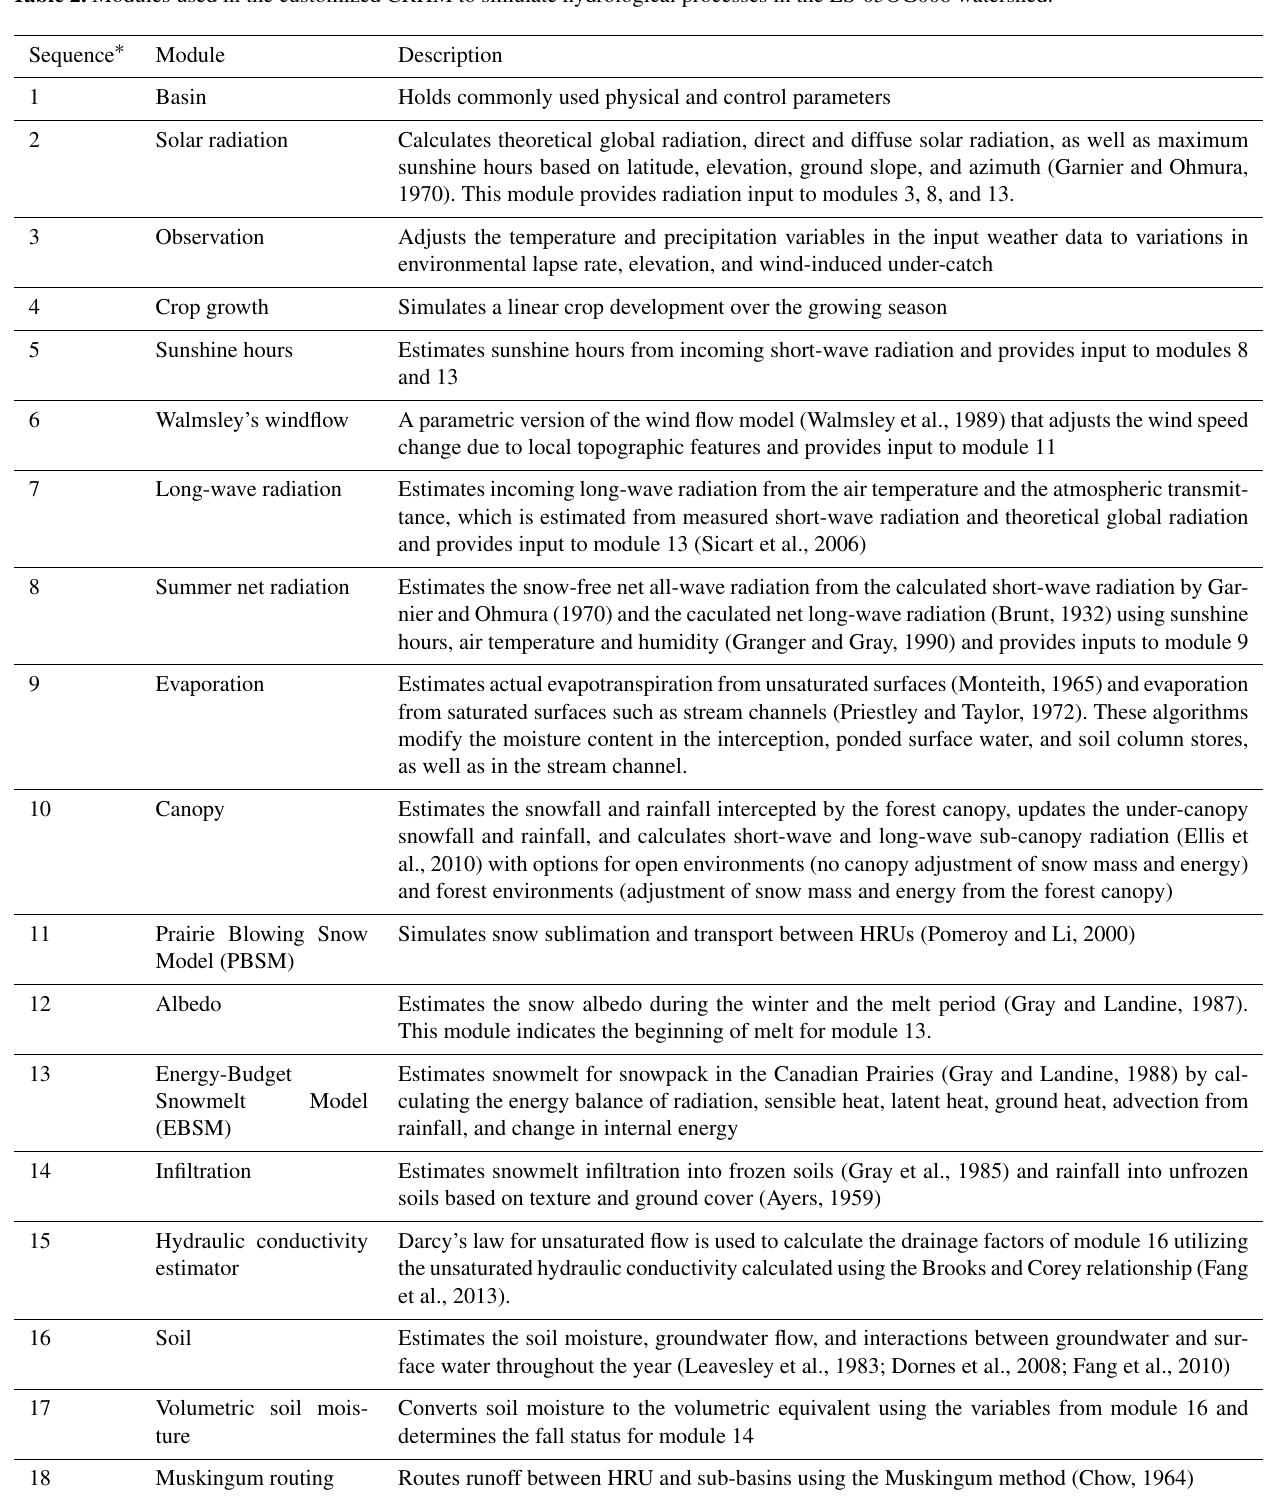
Table 2. Modules used in the customized CRHM to simulate hydrological processes in the LS-05OG008 watershed. Sequence